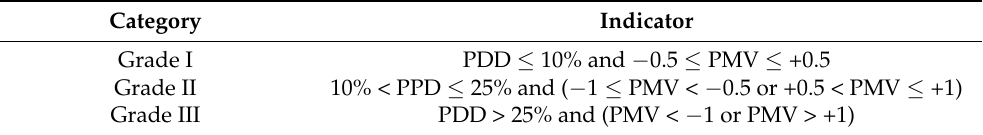
Table 7. Evaluation grade of indoor thermal